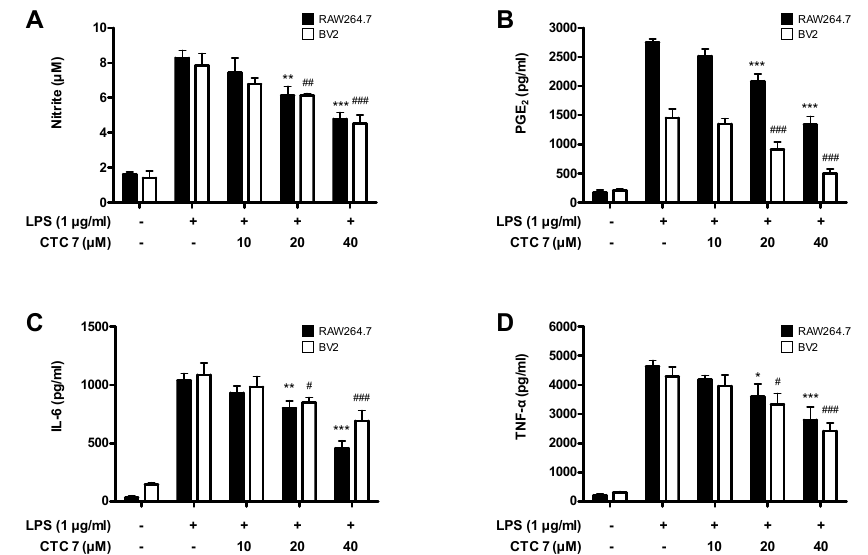
Figure 7. Effects of CTC 7 treatment on nitrite content ( A ) PGE 2 ( B ), IL-6 ( C ), and TNF- α ( D ) expression in LPS-stimulated RAW264.7 and BV2 cells. Cells were pretreated for 3 h with the indicated concentrations of CTC 7 and stimulated for 24 h with LPS (1 μ g/mL). Measurements of nitrite concentrations, a PGE 2 assay, and an enzyme-linked immunosorbent assay (ELISA) were performed as described in the Materials and Methods. Bars represent the mean ± standard deviation for three independent experiments. * p < 0.05, ** p < 0.01, *** p < 0.001, # p < 0.05, ## p < 0.01, ### p < 0.001 compared with the LPS-treated group.